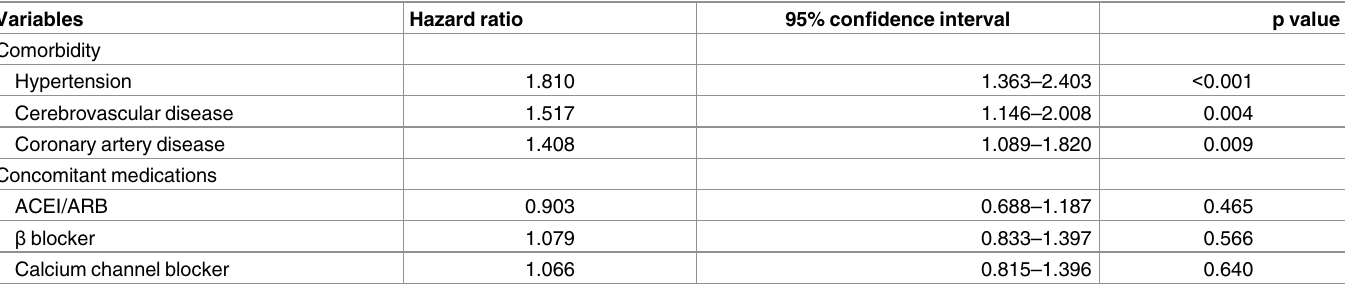
Table 4. Multivariate Cox proportional hazards model to identify clinical factors associatedwith incident DM among COPD patients (n = 1568).